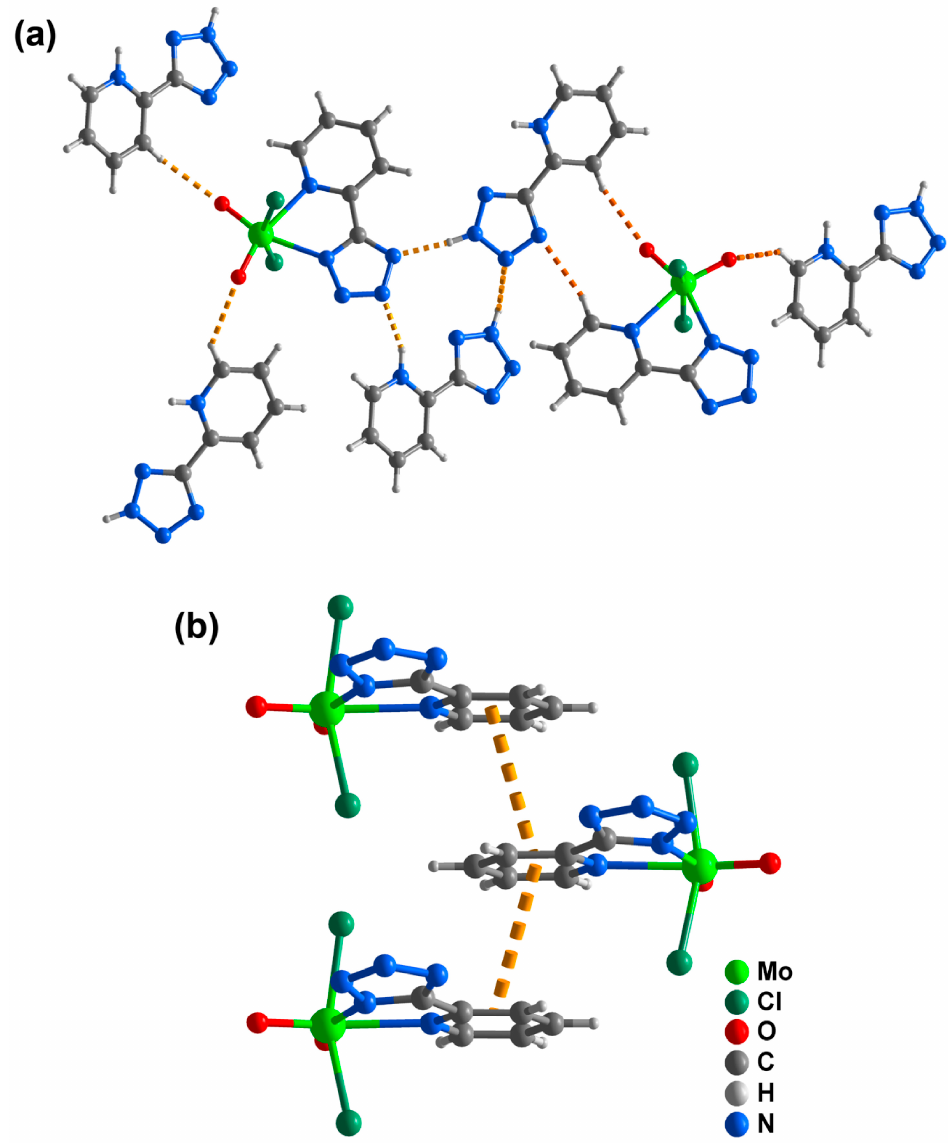
Figure 3. Schematic representation of a portion of the crystal packing of 1 , illustrating: ( a ) the N ‒ H ∙∙∙ N and C ‒ H ∙∙∙ O hydrogen bonding interactions (dashed orange lines) between the oxido, tetrazole and pyridine rings; ( b ) the π‐π interactions (dashed orange lines) between adjacent pyridine rings of coordinated pytz ‒ anionic residues. The atomic labelling was omitted for clarity. The vibrational spectra of 1 show two bands at 945 ± 1 cm − 1 (strong in the IR, very strong in the Raman) and 914–915 cm − 1 (very strong in the IR, medium in the Raman), which are attributed to symmetric and asymmetric Mo=O stretching modes, respectively (Figure 4b and 5b). Another strong IR band at 338 cm ‒ 1 is assigned to ν asym (Mo ‐ Cl). In the Raman spectrum (Figure 5b), the out ‐ of ‐ plane deformation mode, γ (MoO 2 ), occurs as a medium ‐ intensity band at 397 cm − 1 , and there are several bands in the range 150–250 cm − 1 that are attributed to ν sym (Mo ‐ Cl) (210, 238 cm − 1 ) and ν sym (Mo ‐ N) (186 cm − 1 ) vibrations in accordance with previous assignments for related molybdenum(VI) ‐ pyrazolylpyridine complexes [42].